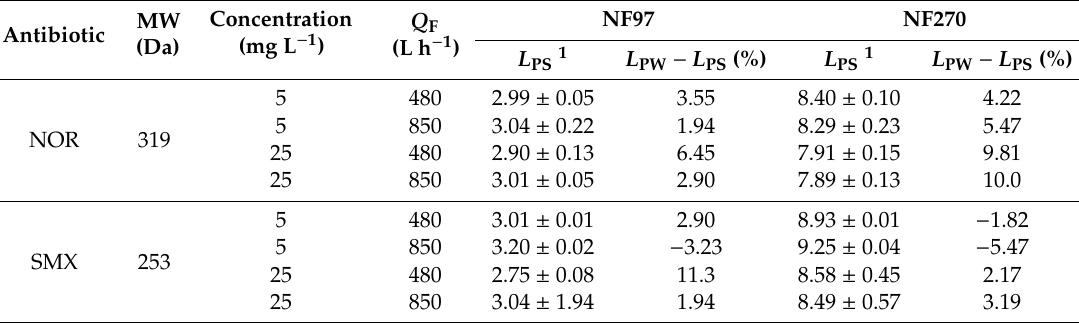
Table 4. E ff ects of the MW and concentration of the antibiotic and of the feed flow rate on the permeability of NF97 and NF270